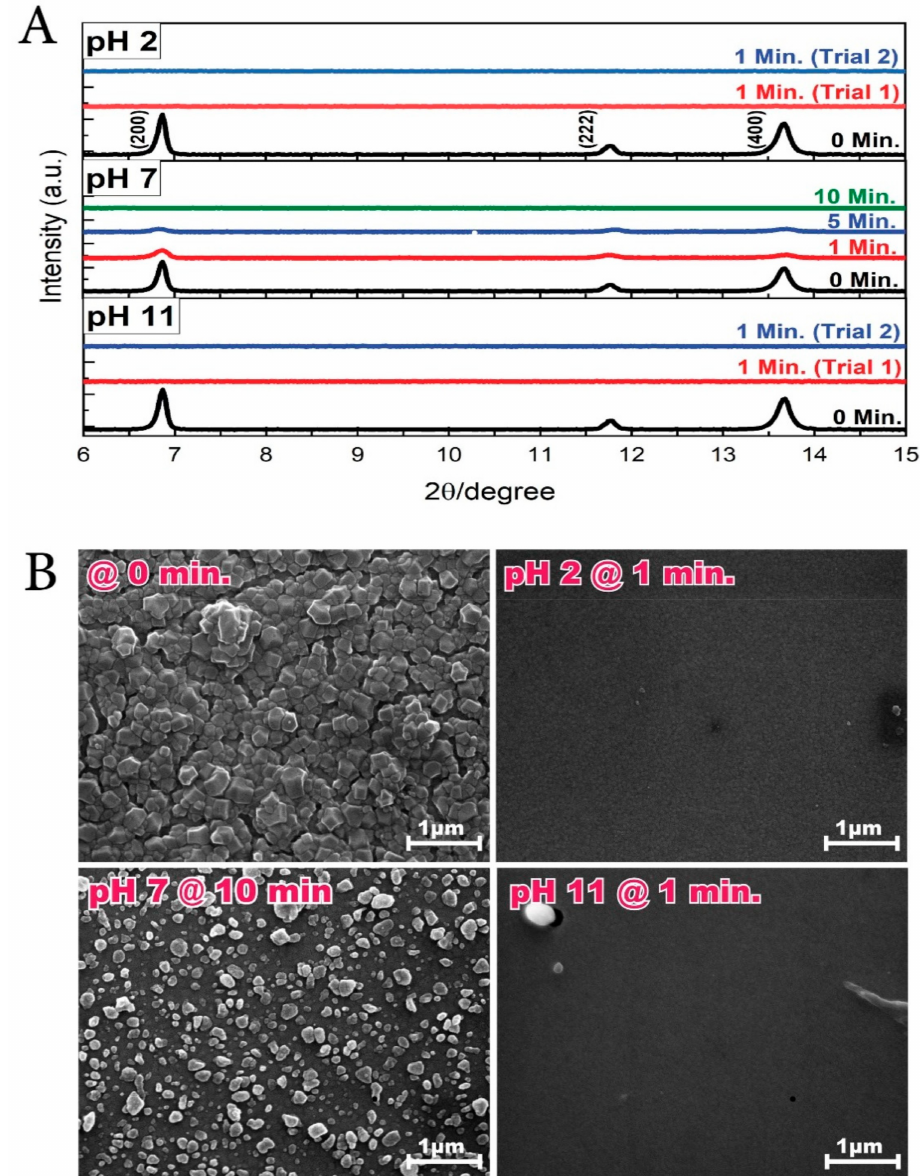
Figure 1. ( A ) X-ray diffraction (XRD) patterns and ( B ) scanning electron microscopy (SEM) images of HKUST-1 SURMOF films immersed in pH 2, pH 7, and pH 11